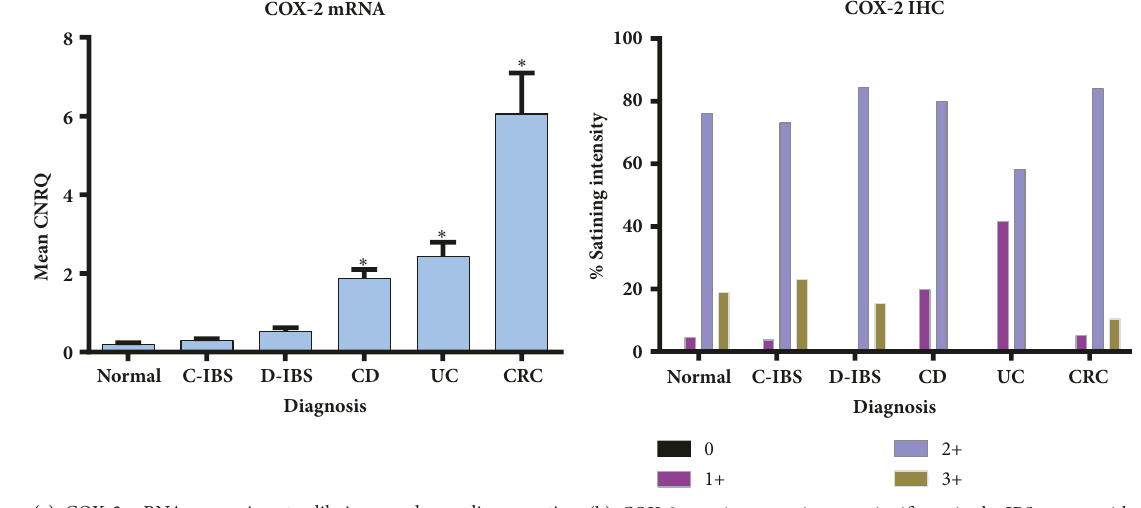
Figure 3: COX-2 expression in the various disease entities. (a) COX-2 mRNA expression. CNRQ = Calibrated Normalized Relative Quantities, normalized to mean for all samples. Total patient number studied = seventy-four (74) with Normal group: fifteen (15) patients, C-IBS group: twenty-two (22) patients, D-IBS group: seven (7) patients, CD group: six (6) patients, UC group: eight (8) patients, and CRC group: sixteen (16) patients. ∗ denotes significantly different versus normal group (p < 0.05). (b) COX-2 IHC. One-hundredand fourteen (114) patient slides analysed with breakdown as follows: Normal group: twenty-six (26) patients, C-IBS: thirty-one (31) patients, D-IBS: thirteen (13) patients, CD: seven (7) patients, UC: twelve (12) patients, and CRC: twenty-five (25)